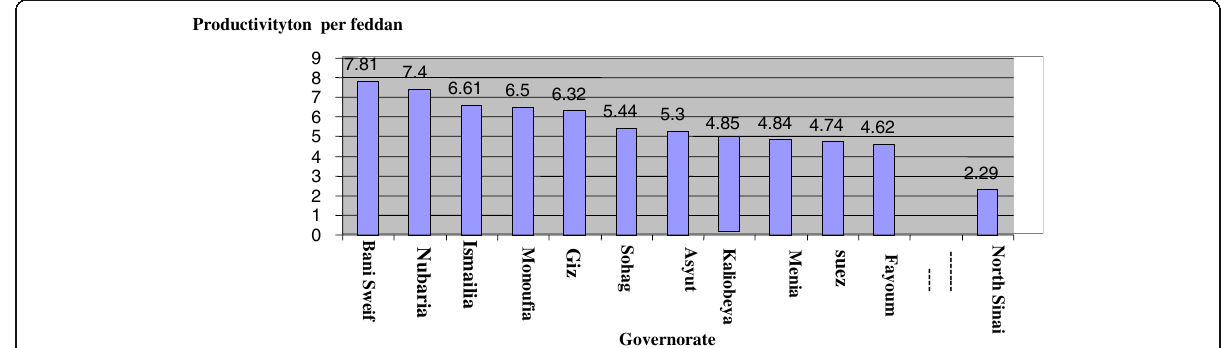
Fig. 2 The productivity of the olive crop in 2012. Source: Abstract of the Agricultural Economy Bulletin, Table (96), Central Administration of Agricultural Economics, Economic Affairs Sector, Ministry of Agriculture and Land Reclamation, Giza, 2013, p.